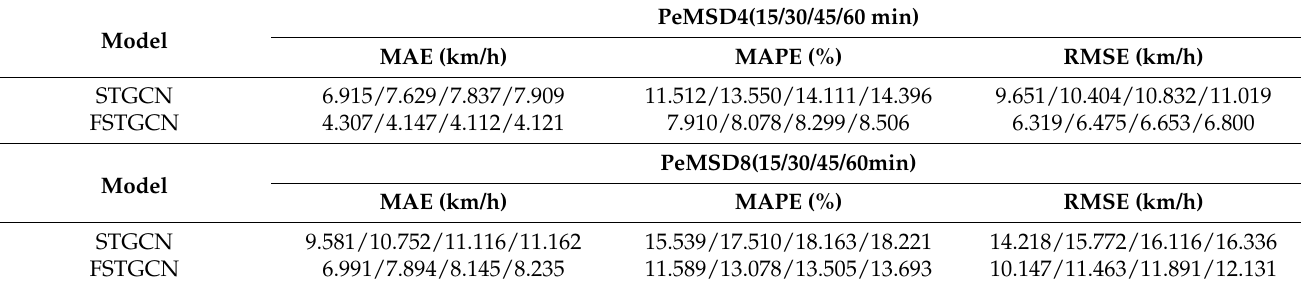
Table 3. Further comparison by adding Gaussian noise on test sets PeMSD4 and PeMSD8.